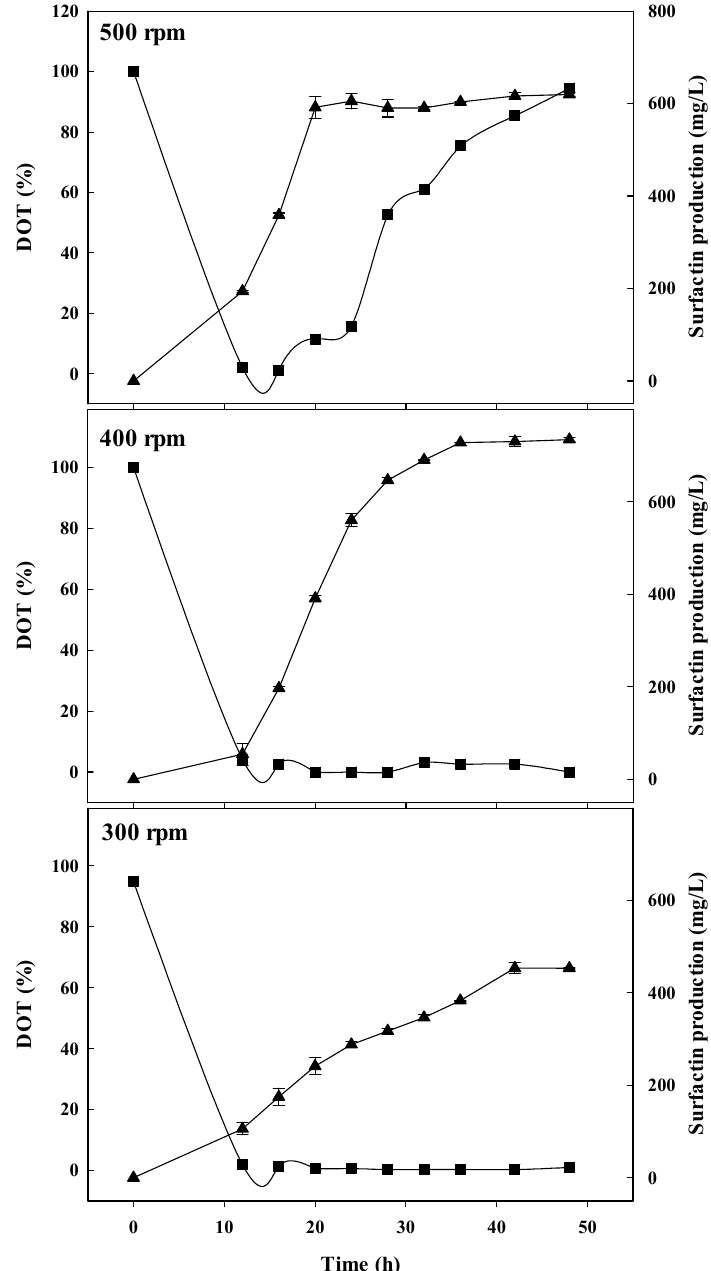
Figure 1. Surfactin production depends on agitation speed. Cultivations were carried out in 5 L jar fermenters for 48 h. Filled triangle, surfactin; filled square, dissolved oxygen tension (DOT). OUR was positively correlated with volumetric surfactin productivity (Figure 2). When the OUR value increased from 0 to 250 s − 1 , volumetric productivity increased up to 45 mg/L · h; however, no further increase was observed in proportion to volumetric productivity when the OUR value was above 255 s − 1 . K L a increased with increasing agitation speed (F = 133.5, df = 2.15, p < 0.001) (Figure 3). The highest K L a , of 0.0235 s − 1 , was observed at 500 rpm, followed by 0.177 s − 1 at 400 rpm, and 0.0138 s − 1 at 300